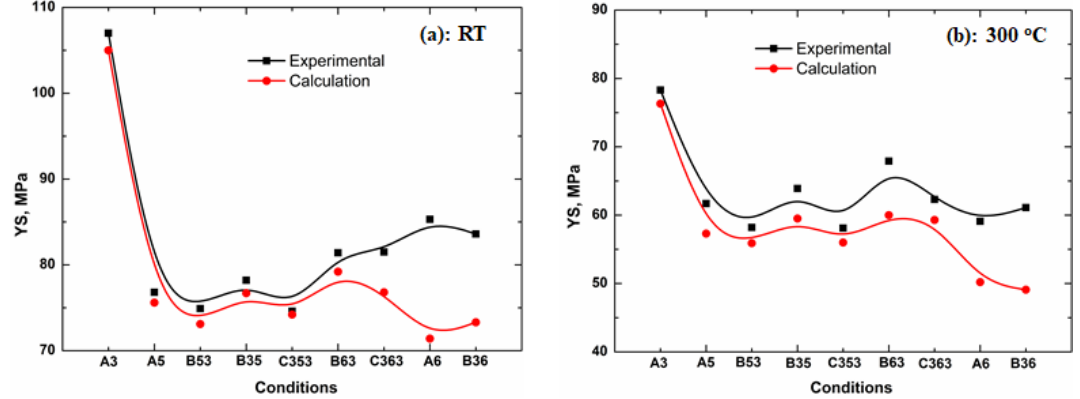
Figure 6 . Experimental and calculated YS at RT ( a ) and 300°C ( b ) after various heat treatments. Figure 6. Experimental and calculated YS at RT ( a ) and 300 ◦ C ( b ) after various heat